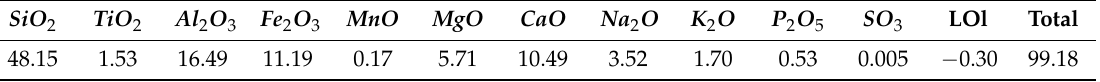
Table 1. X-Ray Fluorescence major elements content, as a component oxide weight percent